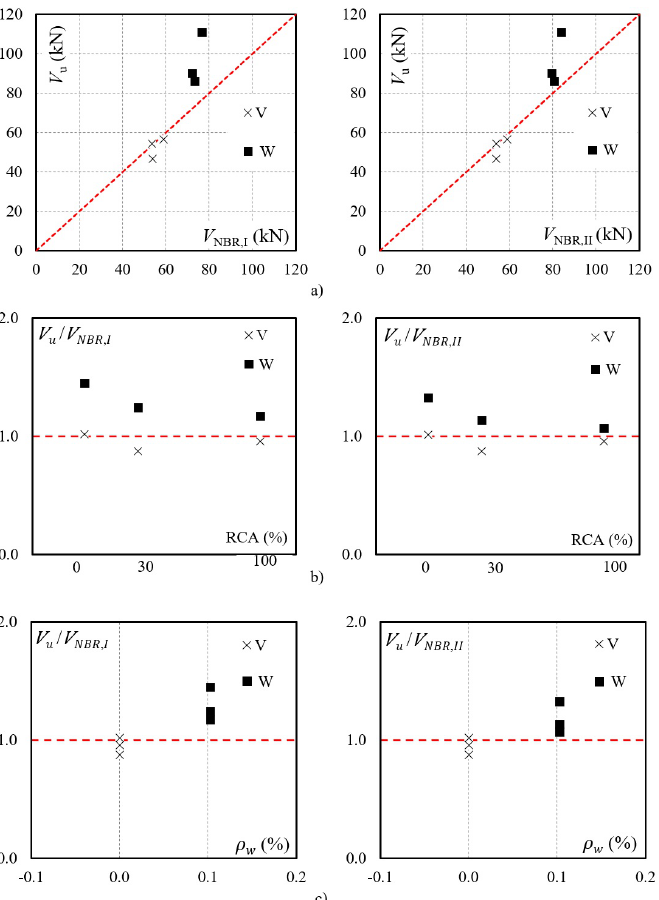
Figure 7 – Comparison between the experimental and theoretical for the tested